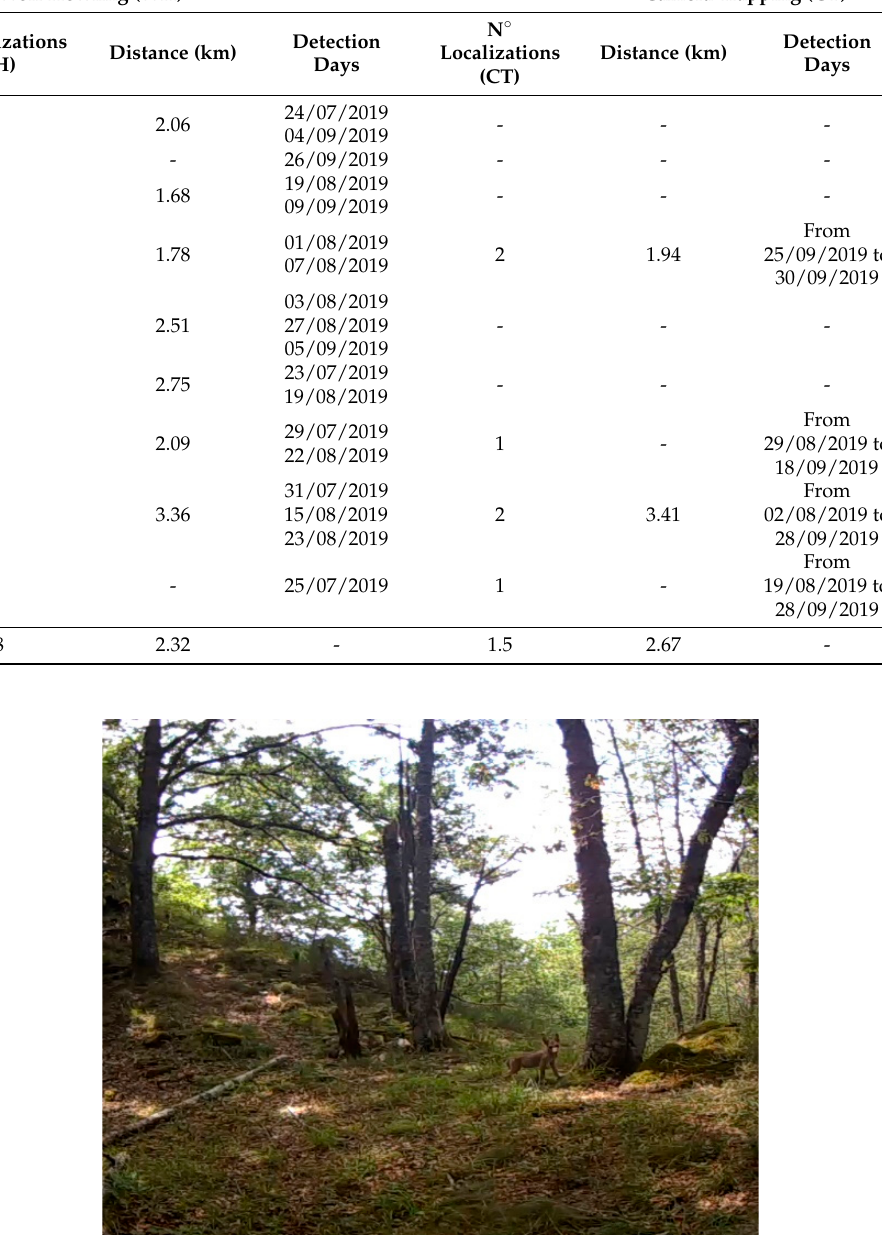
Table 2. Yield (area coverage and packs) and e ff ort (costs and workdays) of each technique: wolf howling, camera trapping, non-invasive genetic sampling and all integrated methods.